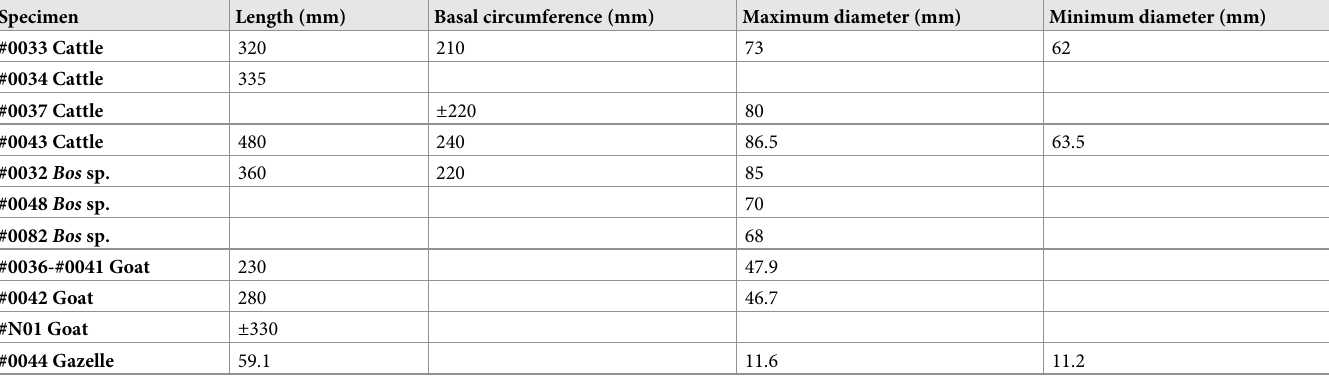
#0036 and #0041 are matching fragments of the same